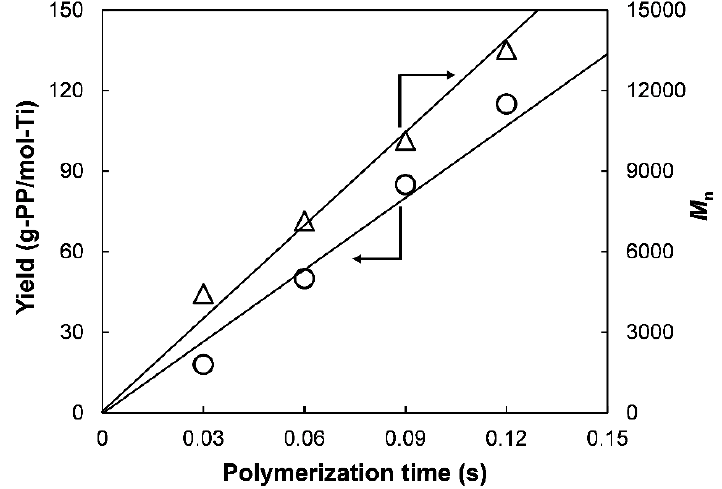
Figure Figure 12. Yield and M n development in short-time LSF propylene polymerization using a TiCl 4 /ethylbenzoate/MgCl 2 co-ground catalyst.